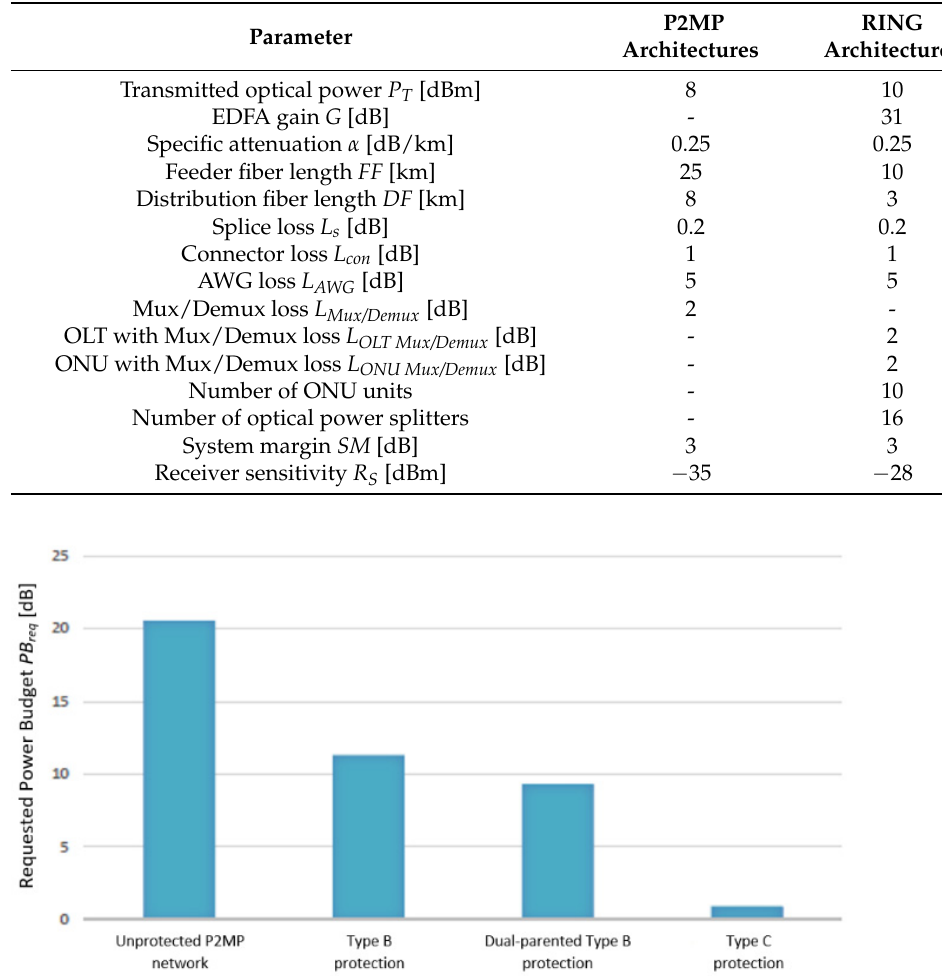
Table 2. Specific parameters’ values for power budget calculations in WDM-PON networks.